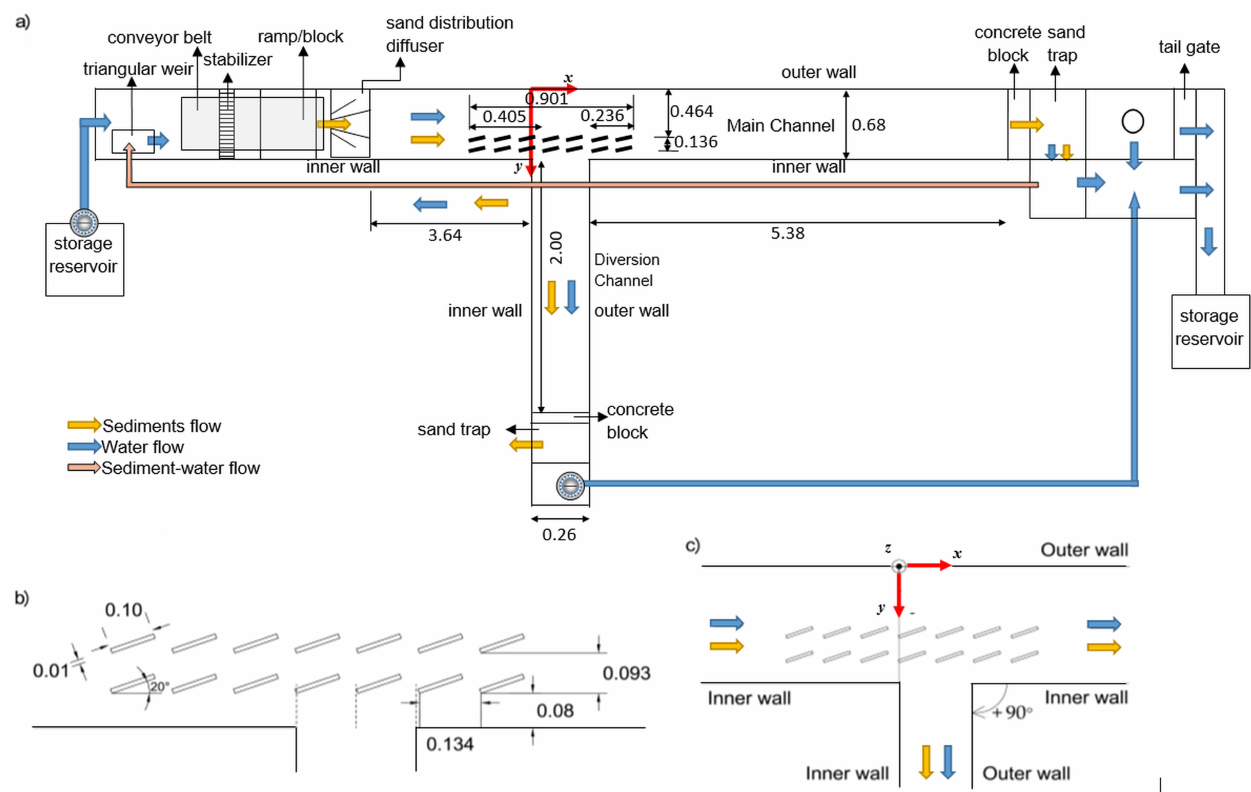
Figure 2. Schematic plan of the channels (dimensions in meter): ( a ) broad plain view. ( b ) detail of the vane-field. ( c ) the origin of the coordinate